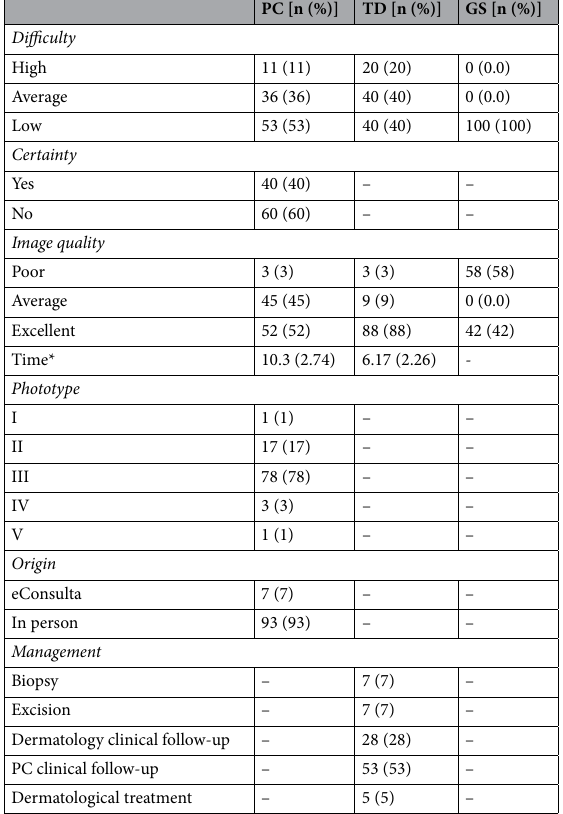
Table 1. Descriptive characteristics of the cases analysed. PC Primary care, TD Teledermatology, GS Gold standard. Variables described by relative frequency and percentage n (%). *Minutes. Mean and standard deviation. Variables that were not asked to all groups of professionals have been marked with the